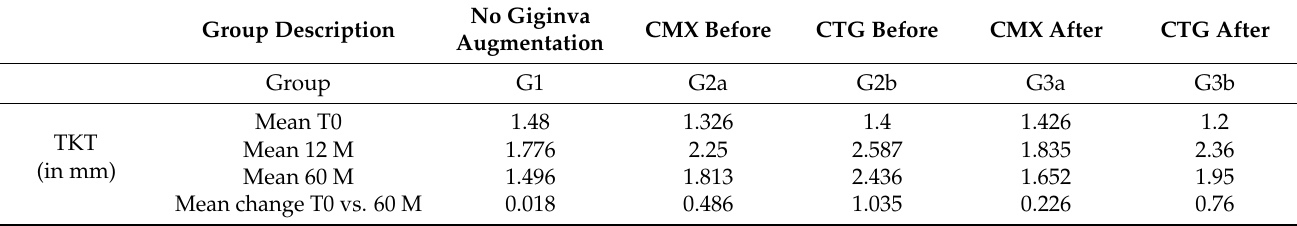
Table 2. TKT in mm. Mean T0—initial value, 12 M—12-month value, 60 M—5 year value. Mean